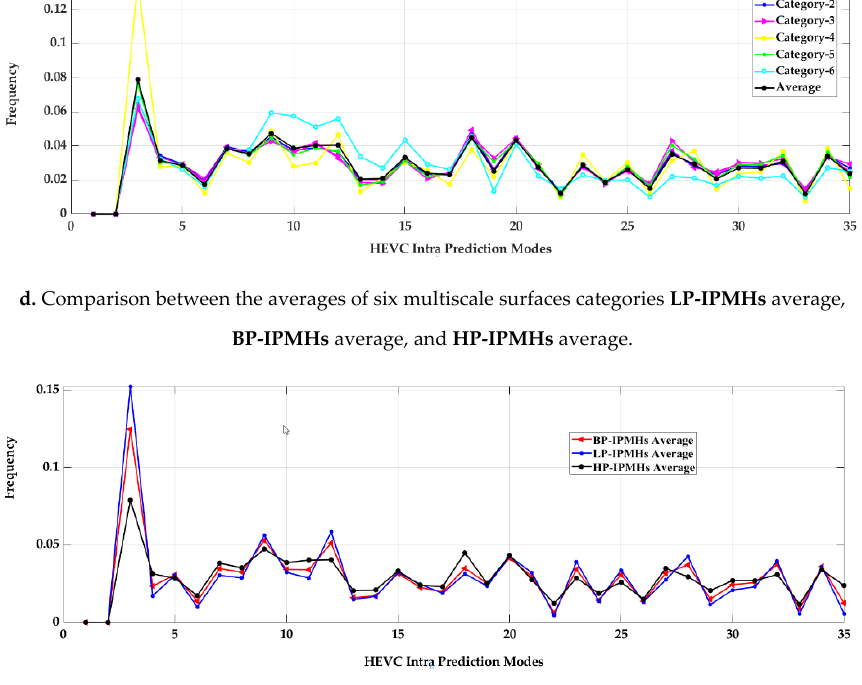
Figure 19. Comparison between the IPMH averages for three di ff erent filtered image data sets: LP, BP, and HP data sets.